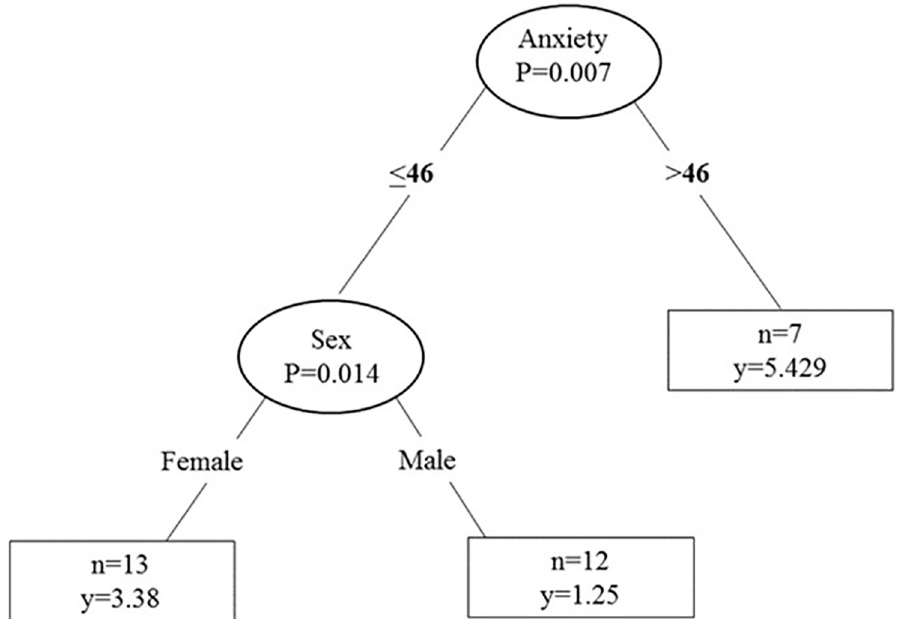
Fig 3. Significant interaction (time by group) for PPTd. The measurement of pain pressure threshold (mean ± standard error) on the Deltoid (PPTd) showed that responders (black solid line) demonstrated a significant decrease in PPTd following eccentric exercise. PPT differences between the sessions were 101kPa for responders; 63 kPa for non-responders (brake black line); and -3kPa for the control group who did not perform the exercise (grey solid line).